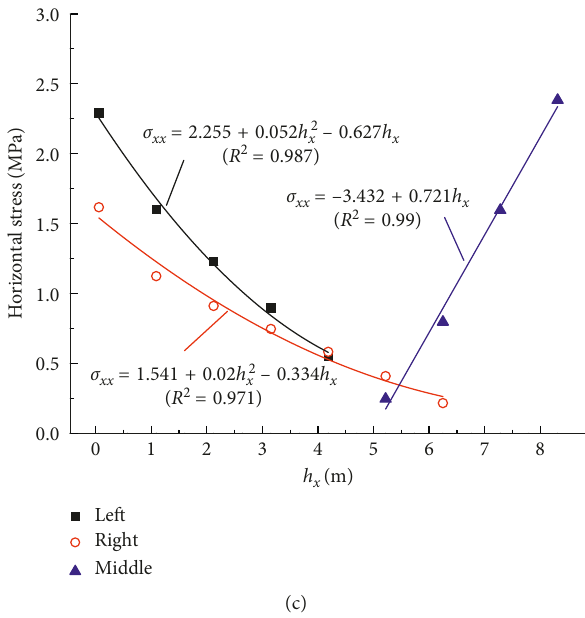
Figure 12: Distribution law of the horizontal stress in the arch structure. (a) L � 10m. (b) L � 14m. (c) L �